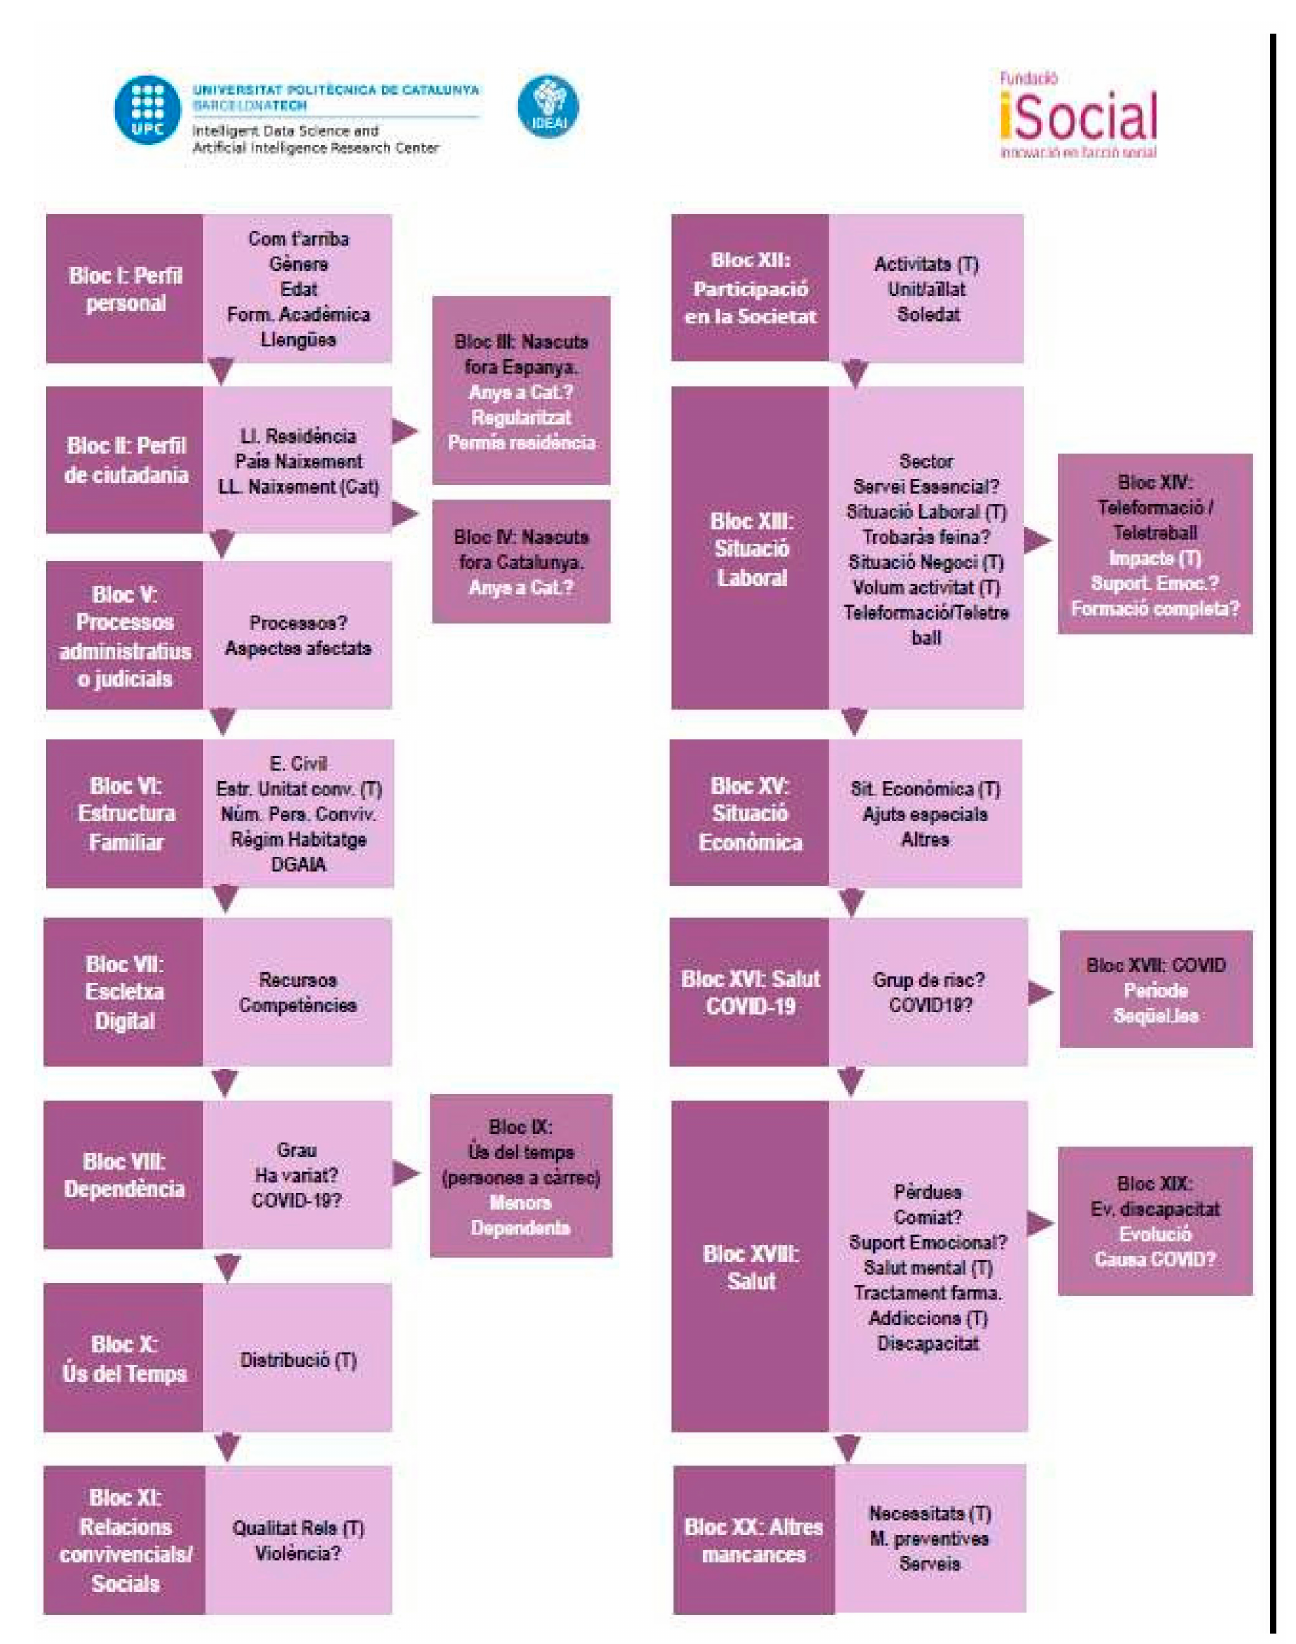
Figure 1. Structure of the INSESS-COVID19